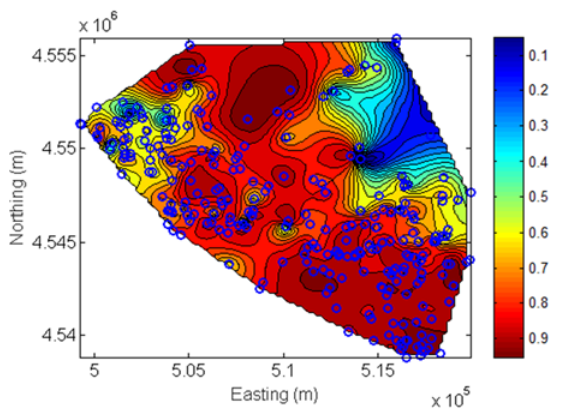
Figure 3. Map of estimated probabilities of the groundwater level of the aquifer to decline below the set 2.5 masl threshold value using